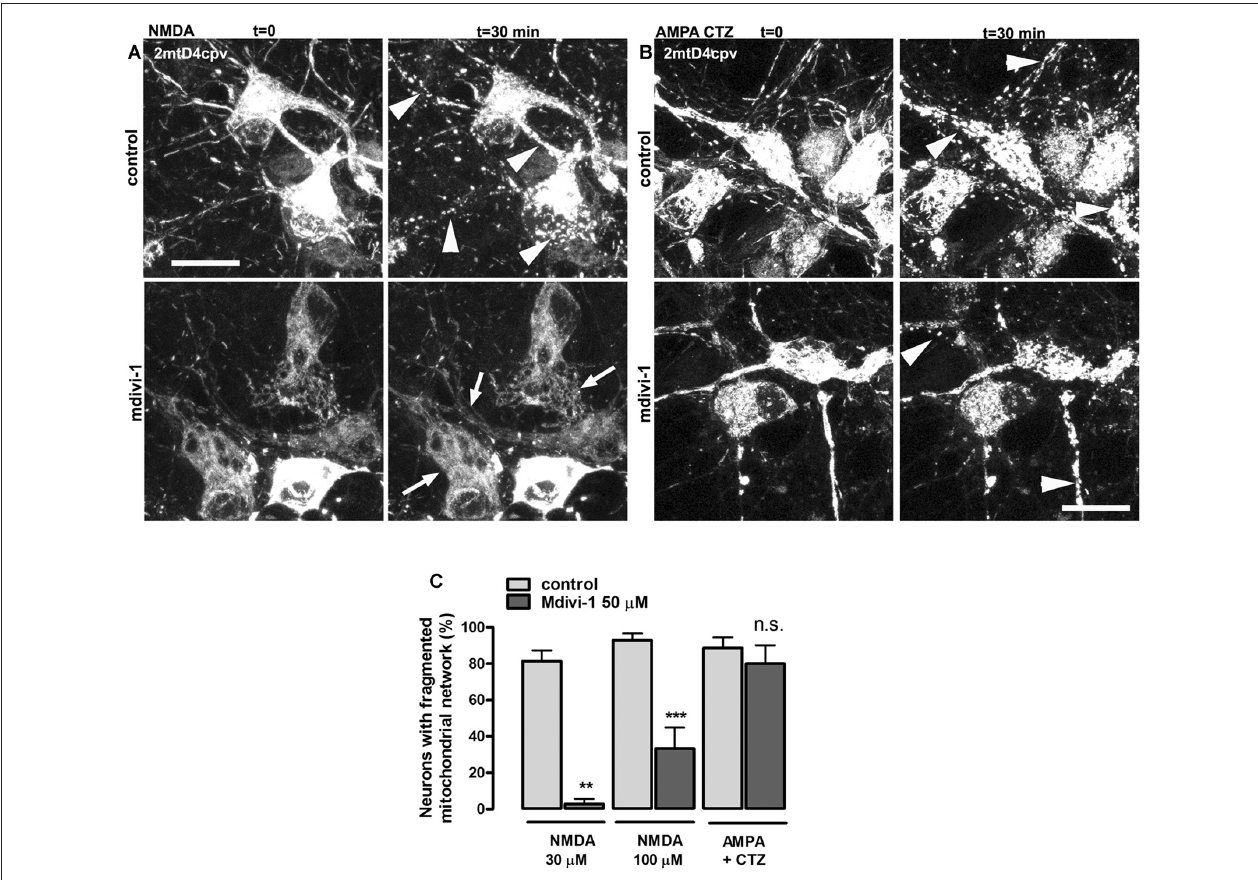
FIGURE 1 | Mitochondrial division inhibitor 1 (mdivi-1) blocks NMDA but not AMPA/cyclothiazide (CTZ)-induced mitochondrial fission. (A,B) Representative time-lapse images of NMDA- and AMPA/CTZ induced mitochondrial fragmentation. Neurons transfected with mitochondria-targeted 2mtD4cpv were exposed to 30 µ M or 100 µ M of NMDA or 25 µ M of AMPA plus CTZ (100 µ M) for 30 min in the presence or absence of preincubated (1 h) mdivi-1 (50 µ M). Arrows and arrowheads indicate representative neurons with non-fragmented and fragmented mitochondrial network respectively. Scale bar: 20 µ m. (C)